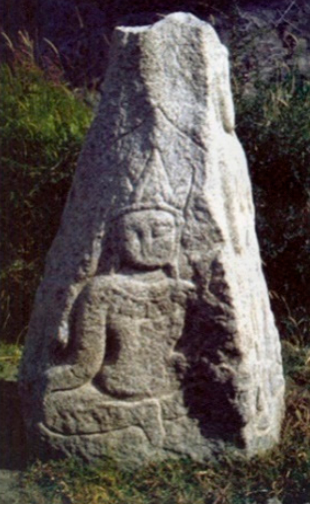
Figure 12. Crowned Buddha, seventh century. Side one of a three-sided stone sculpture from Gilgit. Photograph courtesy of John C. Huntington.